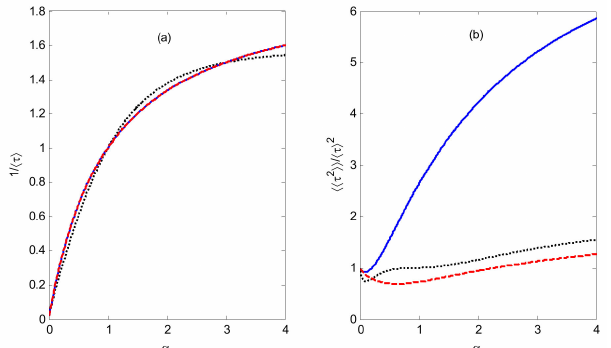
Figure 4. ( a ) 1/ (cid:104) τ (cid:105) as a function of α = Γ r / Γ l . ( b ) The randomness parameter, (cid:104)(cid:104) τ 2 (cid:105)(cid:105) / (cid:104) τ 2 (cid:105) , as a function of α . The blue solid line is constructive ( η = 1), red dashed line is destructive ( η = − 1), and black dotted line is η = exp ( i π /2 ) . Variable α stands for the asymmetry of the dot-state couplings to the left and right leads. δε = Γ l = Γ 0 .